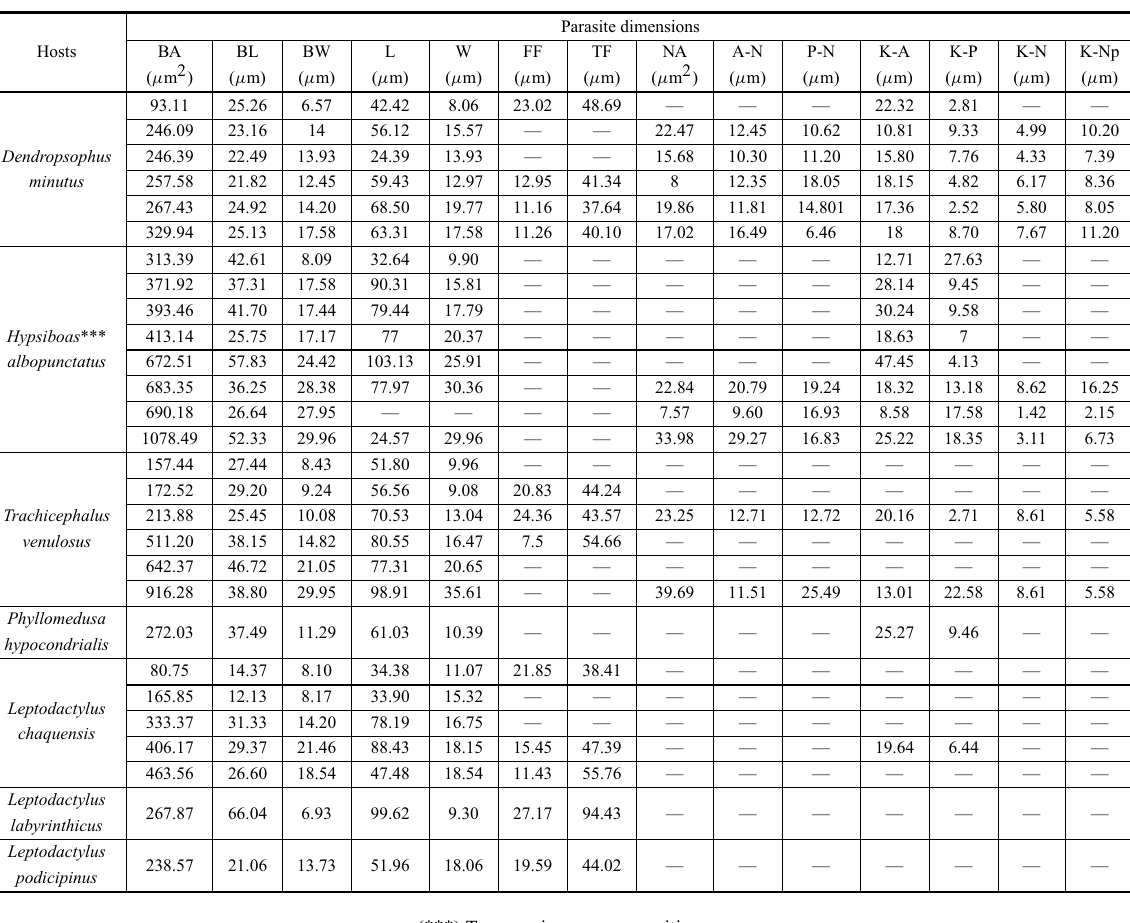
Fig. 5 – Trypanosoma spp. morphometrical parameters observed in seven species of anurans captured in São Paulo and Mato Grosso do Sul States –